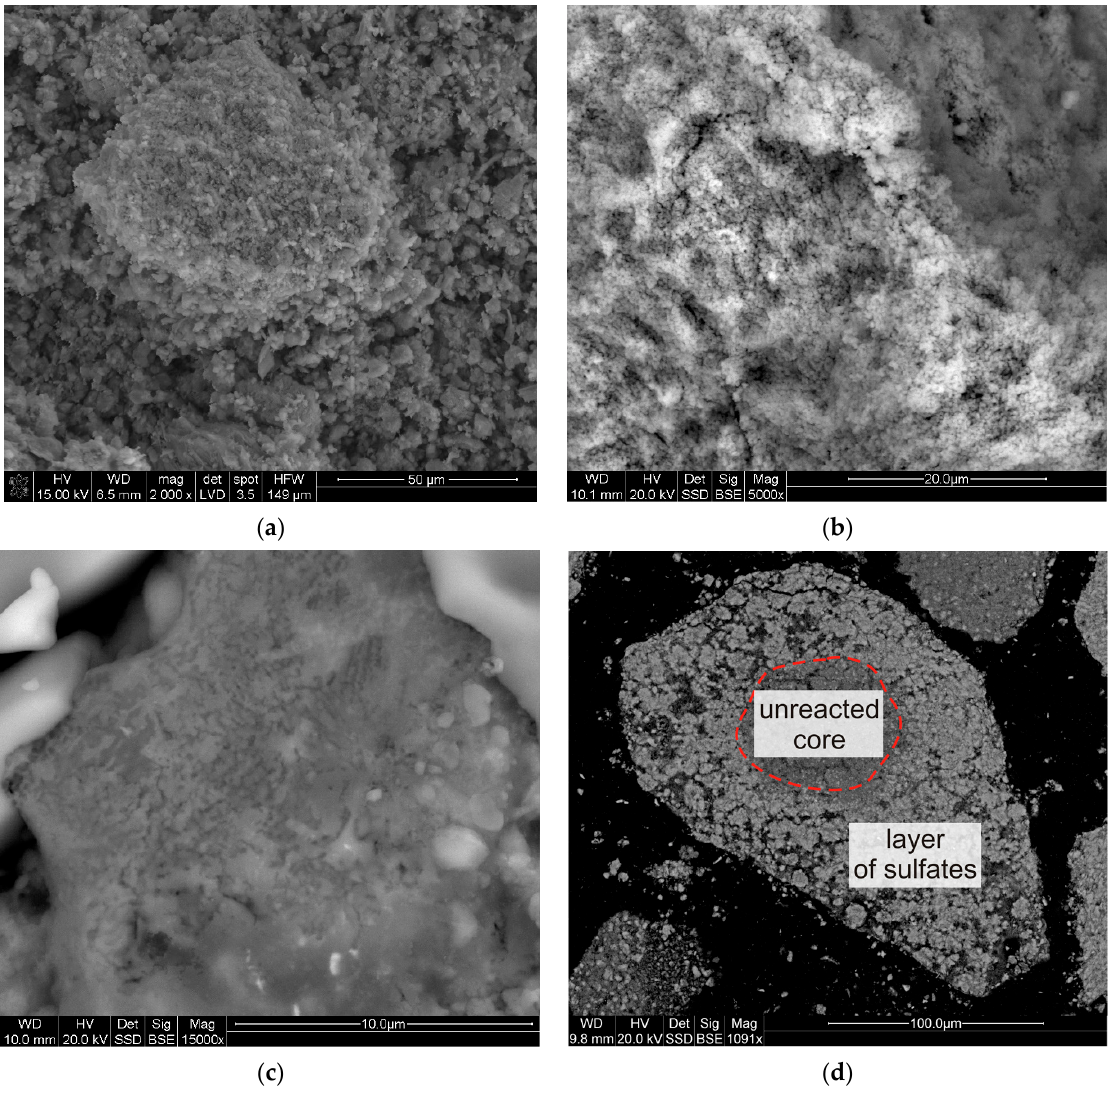
Figure 11. Magnesite from Braszowice: ( a ) natural sample; ( b ) samples after the decarbonation process; ( c , d ) after the sulfation process; ( c ) grain surface; ( e ) cross-section through the grain.